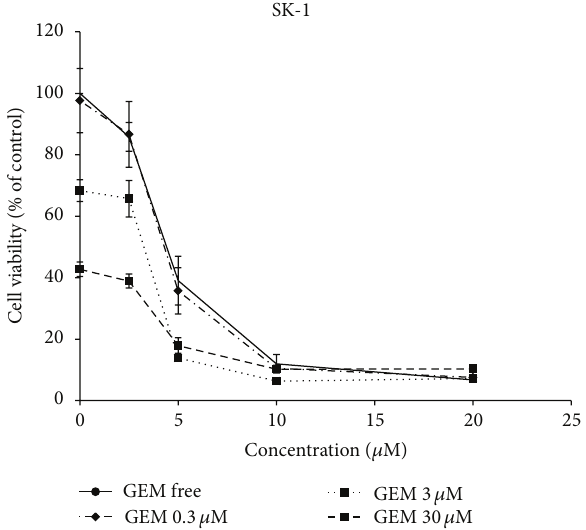
Figure 3: Cytotoxic activity by combination therapy of IL-4R 𝛼 - lytic hybrid peptide with gemcitabine. SK-1 was incubated with various concentrations of IL-4R 𝛼 -lytic hybrid peptide (0–20 𝜇 M) and gemcitabine (0–30 nM). The results are represented as mean ± SD (bars) of triplicate determinations, and the assay was repeated three times.